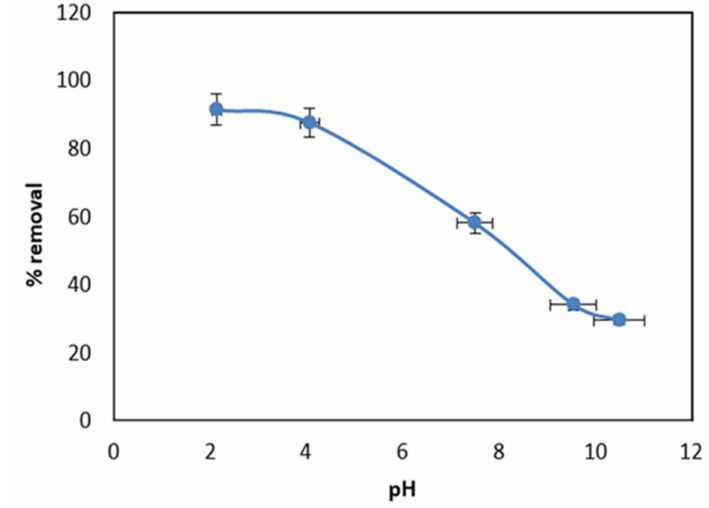
Figure 5. Effect of solution pH on MO uptake by MnO 2 /PF biochar at contact time, 24 h; initial concentration of MO, 10 mg/L; and 0.07 g of MnO 2 /PF .